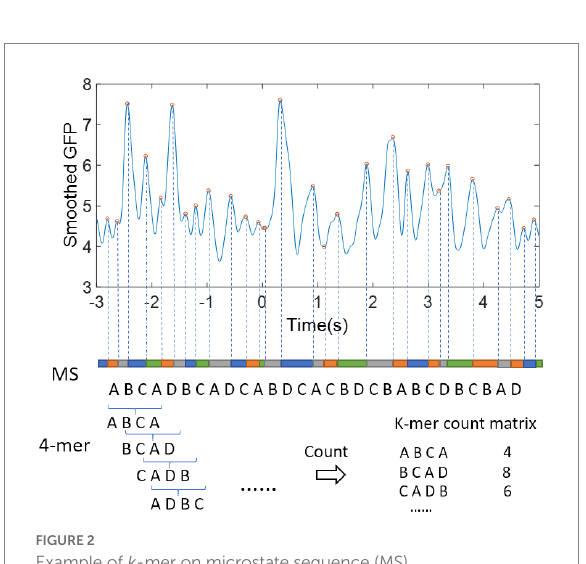
FIGURE 2 Example of k -mer on microstate sequence